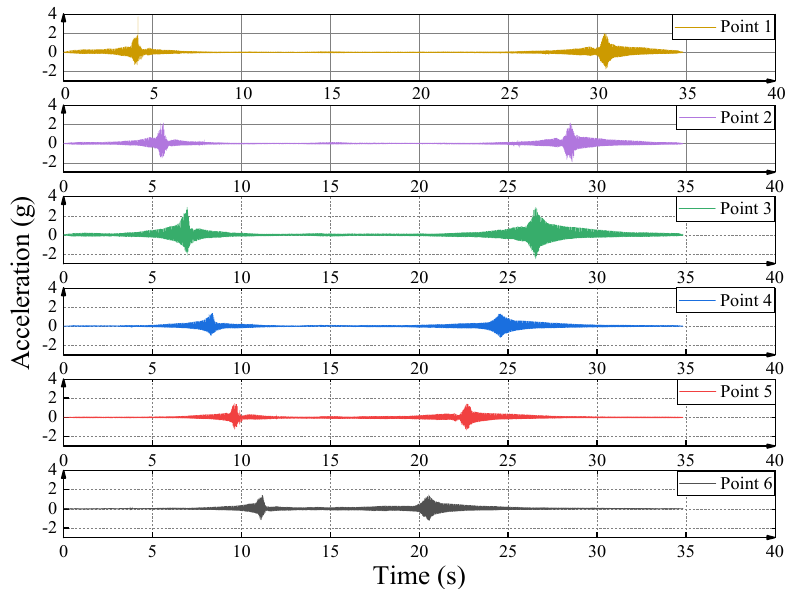
Figure 5. Time − history curve of accelerations from point 1 to point 6. The acceleration peak at each measurement point can be studied by obtaining the data from the acceleration sensors buried at six measurement points on the surface of the fill, and then the acceleration peak propagation coefficient at the remaining measurement points can be studied when the vibratory roller passes through a certain measurement point, as shown in Figure 6. Analysis of Figure 6 shows that the acceleration peak value decreases significantly along the direction of advance of the vibratory roller as the vibra- tion wave in the filler soil.